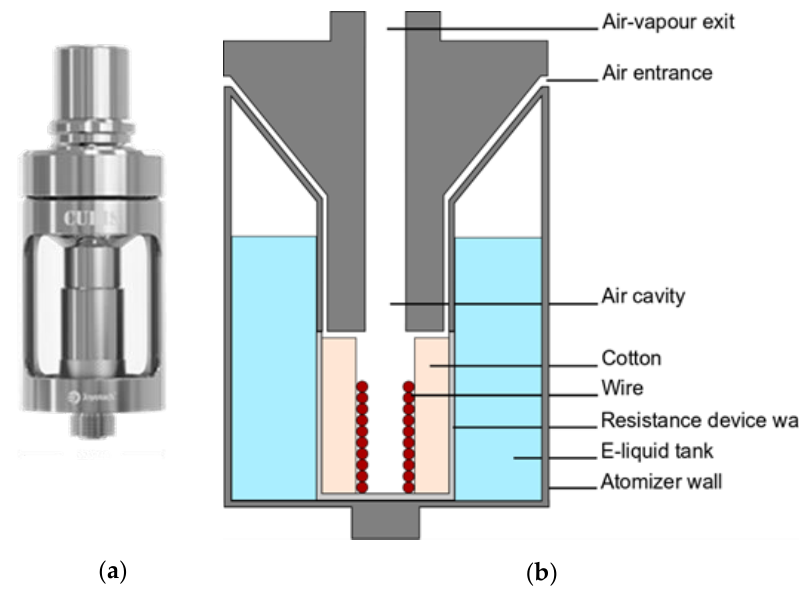
Figure 1. ( a ) Picture of the Cubis clearomiser and ( b ) sectional scheme.